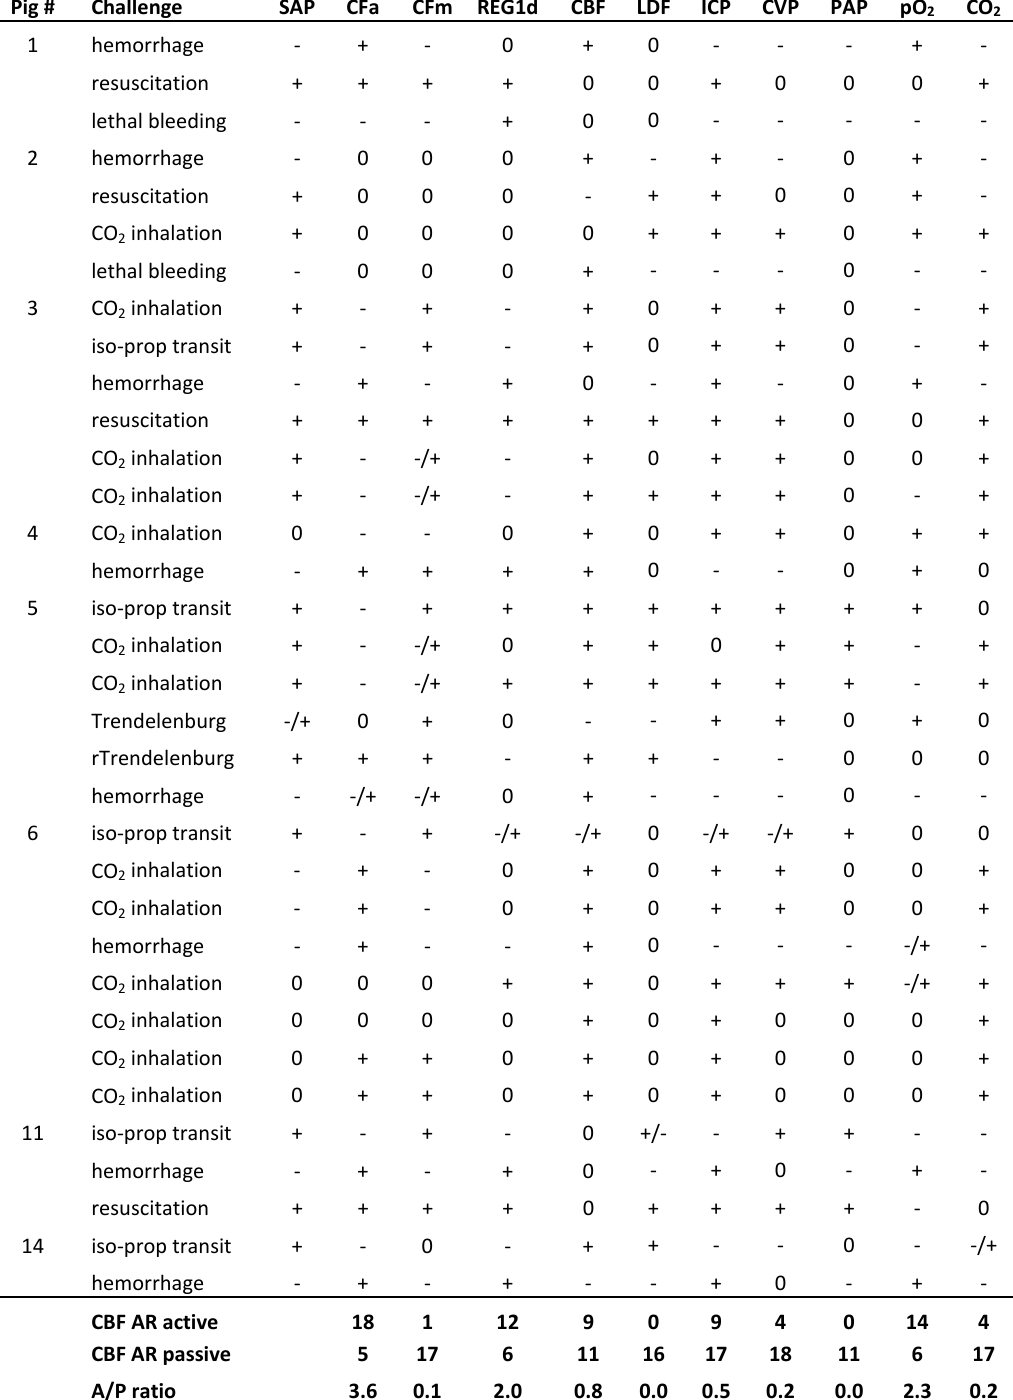
Table 1: Summary of CBF AR changes during challenges in hemorrhage group. CBF AR status was calculated as the relationship to SAP change: identical change of modality CBF AR was considered as passive (-); in case of inverted phase, CBF AR was considered as active (+). Artifact contaminated signals, mixed change or lack of signal were excluded from evaluation (0). Legend: SAP: systemic arterial pressure; CFa: carotid flow pulse amplitude; mean: CFm: mean pulse amplitude; REG1d: REG first derivative; CBF: absolute blood flow; LDF: laser Doppler flow; ICP: intracranial pressure; CVP: central venous pressure; PAP: pulmonary arterial pressure; pO 2: pulse oximetry pulse amplitude; CO 2 : exhaled CO 2 concentration; +: increase - i.e. identical change; -: decrease - i.e. opposite phase; 0: no data or artifact, no change; Trendelenburg: Trendelenburg position; rTrendelenburg: reverse Trendelenburg position; iso-prop transit: transition of anesthesia from isoflurane to propofol; A/P ratio: ratio of active/passive CBF AR